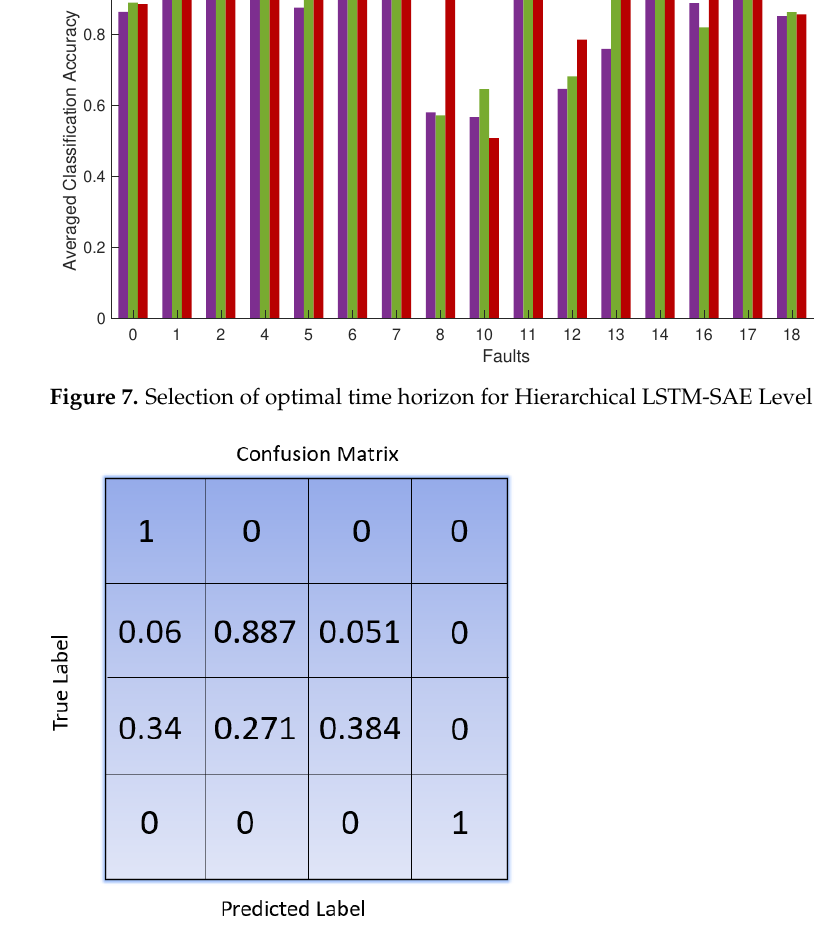
Figure 8. Confusion matrix on test data for the second level model of the hierarchical structure: after adding designed PRBS signal with respect to fault 15.